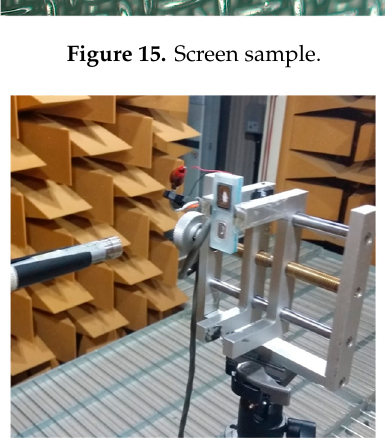
Figure 16. Setup of the sound-pressure level (SPL) experiment.